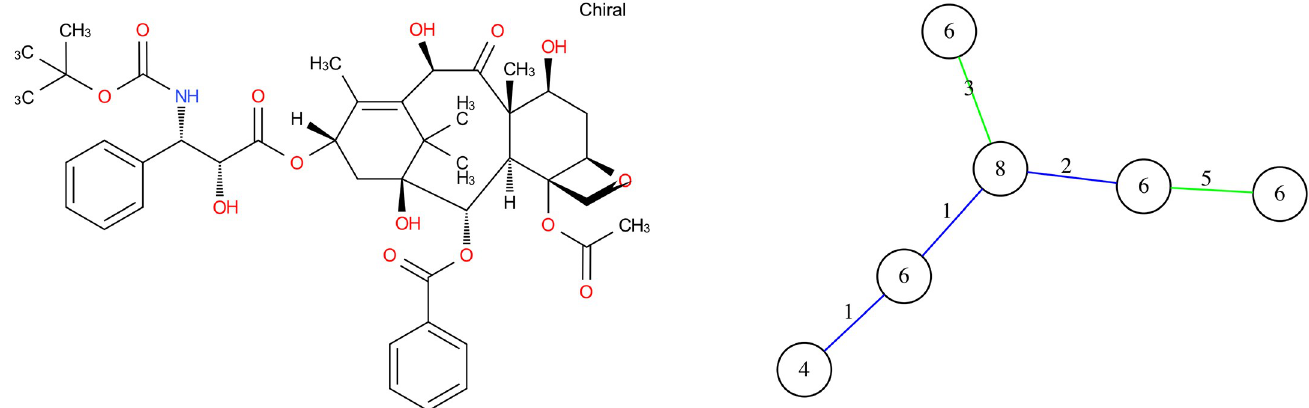
Fig 8. Molecular graph and graph of cycles of Docetaxel Anhydrous. According to the definition of the graph of cycles, we compute the graph of cycles of the molecule Docetaxel anhydrous.